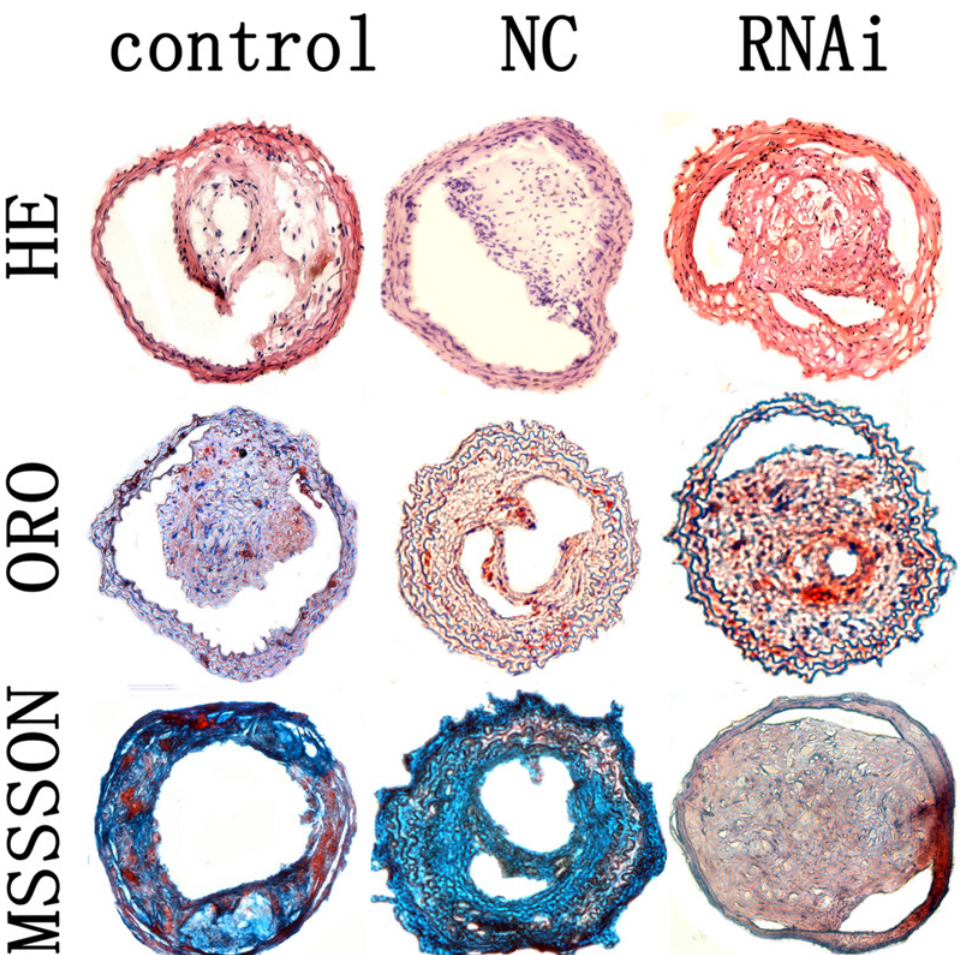
Fig 5. Carotid plaques in the control, NC and MEF 2A RNAi groups. Cross-sections of plaques in the control, NC and RNAi groups were stained with HE, ORO and masson ’ s trichrome. magnification